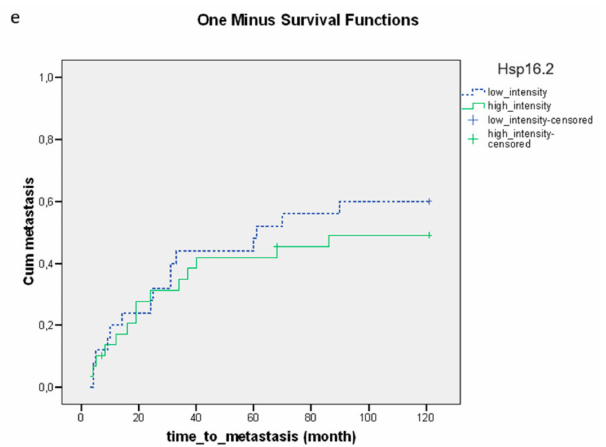
Figure 3. The relationship between the staining of the pretreatment proteins ( a ) p-Akt ( p = 0.000), ( b ) GHRH-R ( p = 0.000), ( c ) Hsp90 ( p = 0.115), ( d ) SOUL ( p = 0.310) and ( e ) Hsp16.2 ( p = 0.328) and the time to metastasis. The effects of biological markers on the time to metastasis were demonstrated using Kaplan–Meier curves and the level of significance was determined using the log-rank test. Probability ( p ) values < 0.05 were considered statistically significant. The tumors localized in the lower third of the rectum were associated with a signifi- cantly longer time to metastasis (Figure 4b). No significant relationship could be detected between the time to surgery, histopathological response, gender and time to metastasis (Figure 4a,c,d).